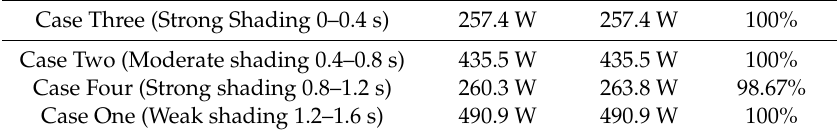
Table 4. Performance analysis of the proposed algorithm under a sequence of four cases.